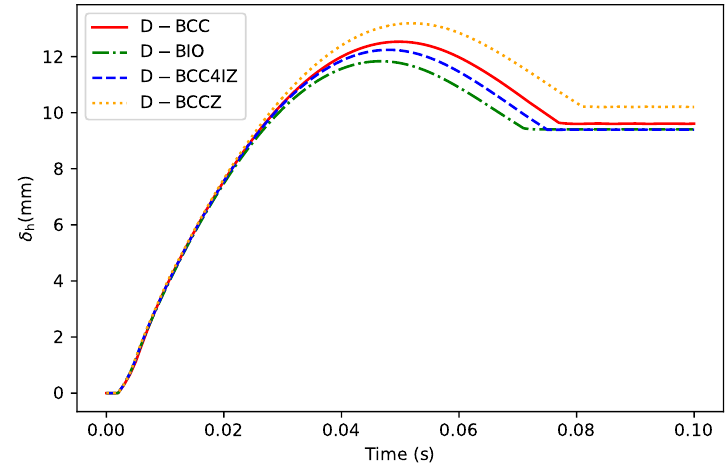
Figure 20. Comparison of δ h